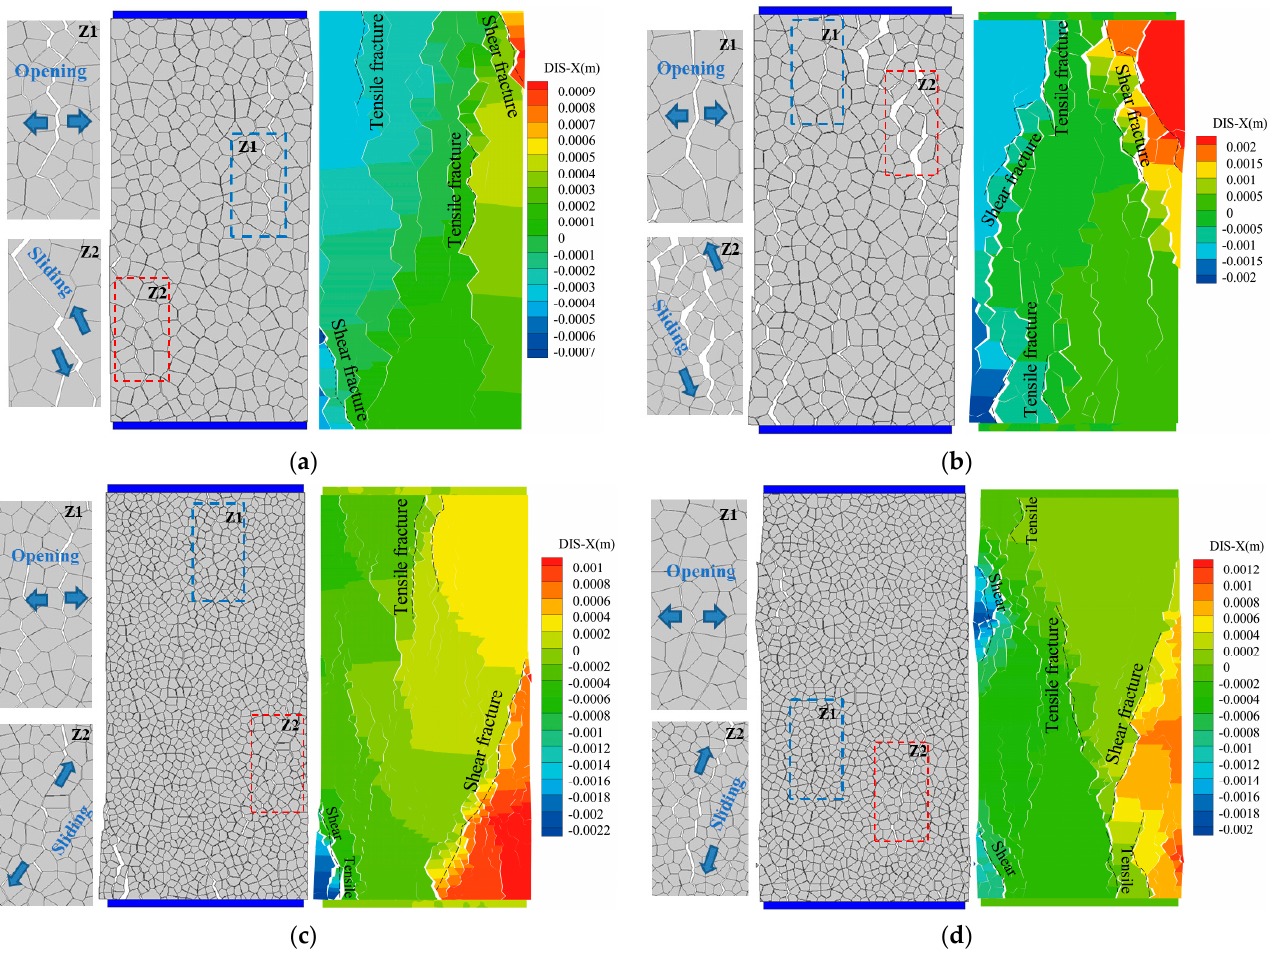
Figure 10. Macroscopic fracture propagation and Horizontal displacement contour of various rock specimens. ( a ) LdB granite, ( b ) Augig granite, ( c ) TS, and ( d ) coal. Note: Insets Z1 and Z2 are zoomed-in plots.